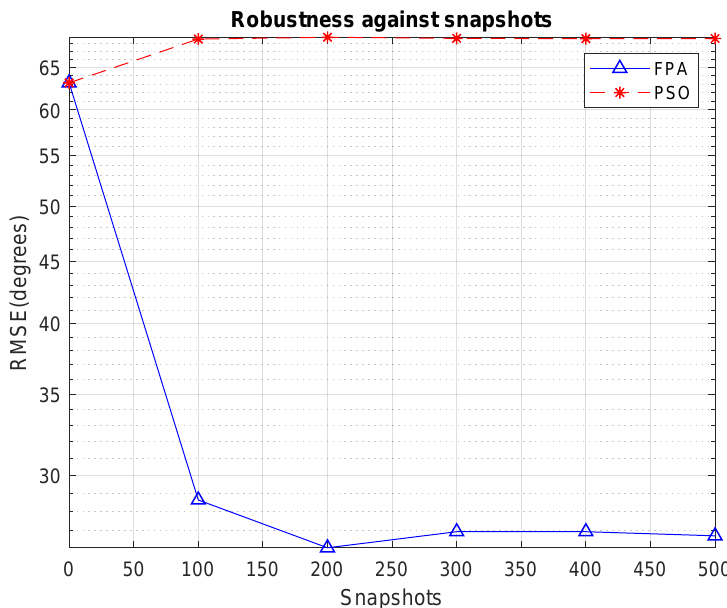
Figure 9. Robustness against snapshots for eleven targets.